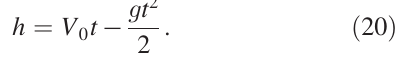
FIG. 20. Predicted lift height reached 20 ms after the beam pulse as a result of Coulombic forces emanating from deposited charge.